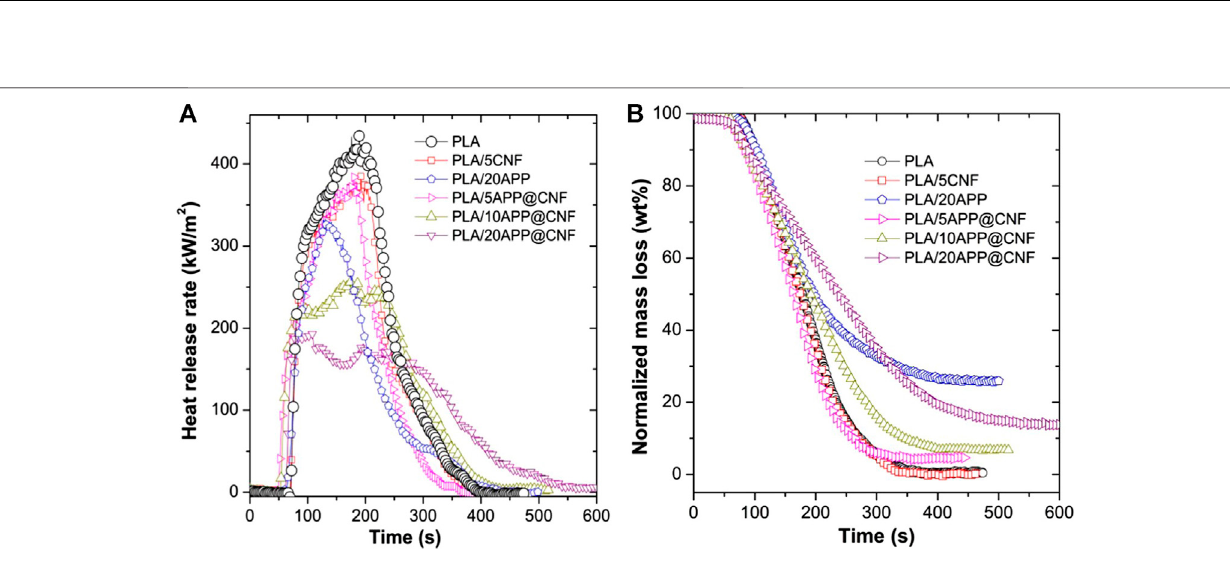
Frontiers in Materials |